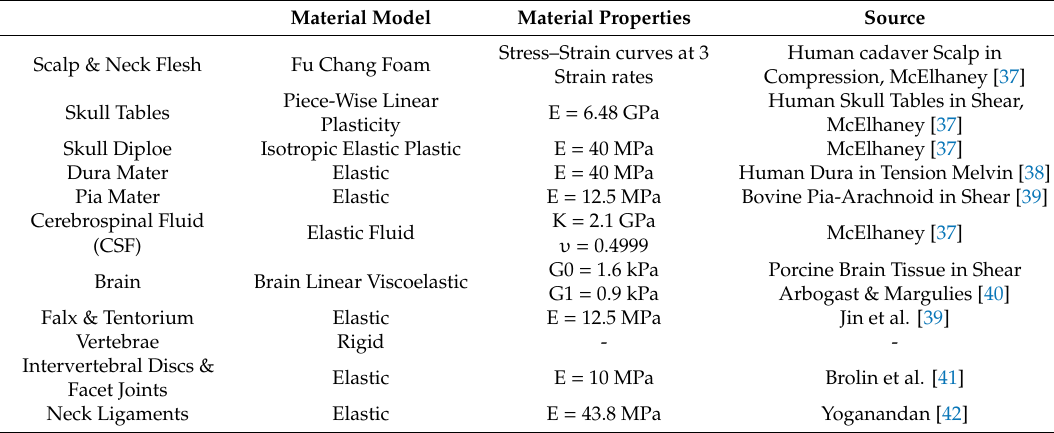
Table 4. Material properties of partially validated cranio-cervical region.